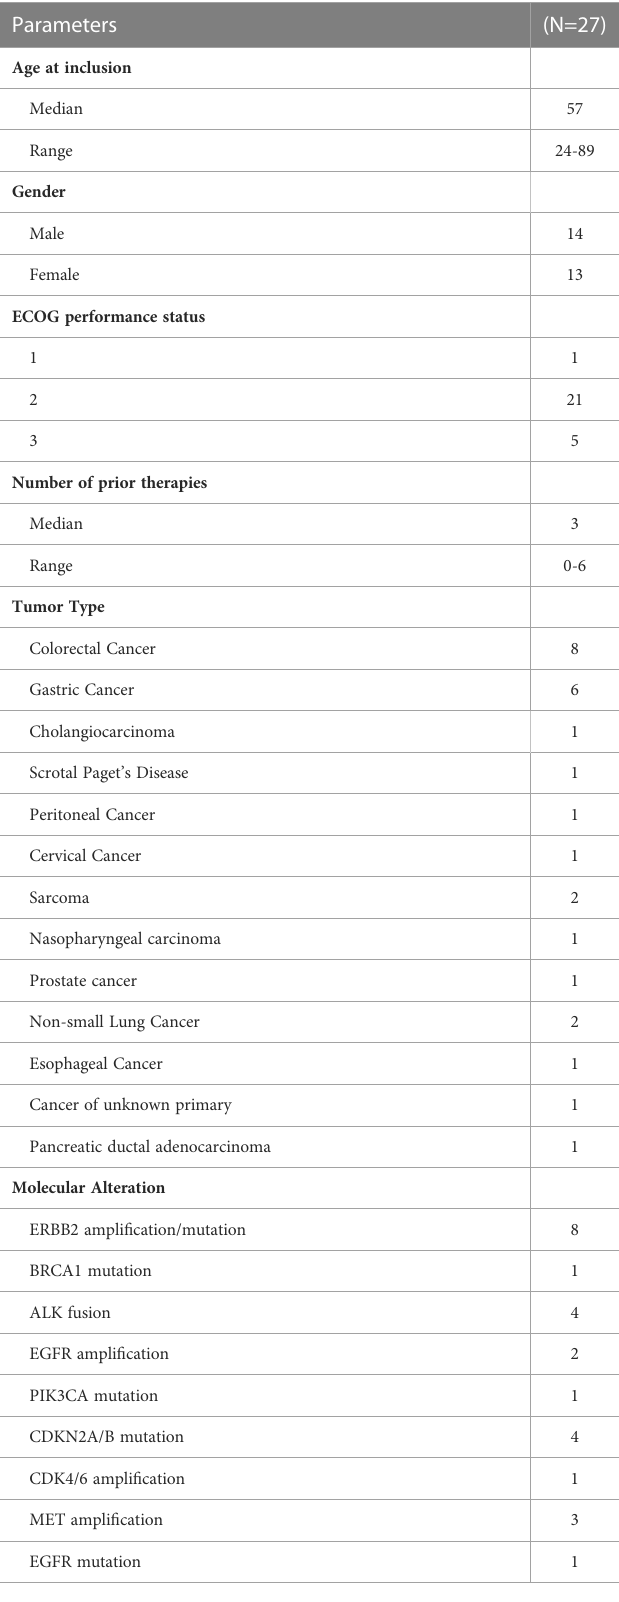
TABLE 1 Clinical characteristics of 27 patients receiving molecular-guided targeted